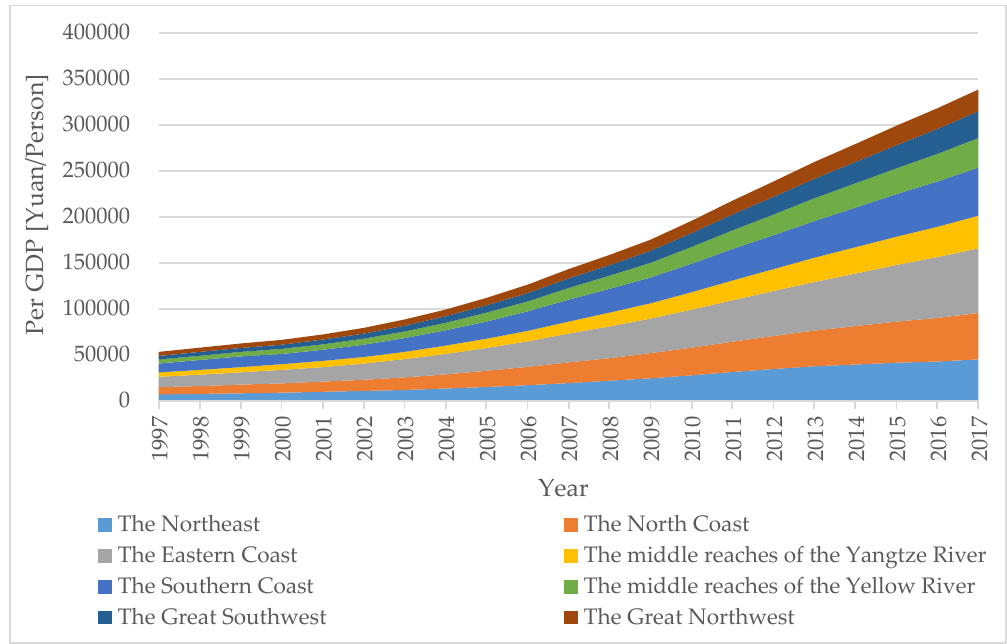
Figure 6. Regional economic output of China from 1997 to 2017.